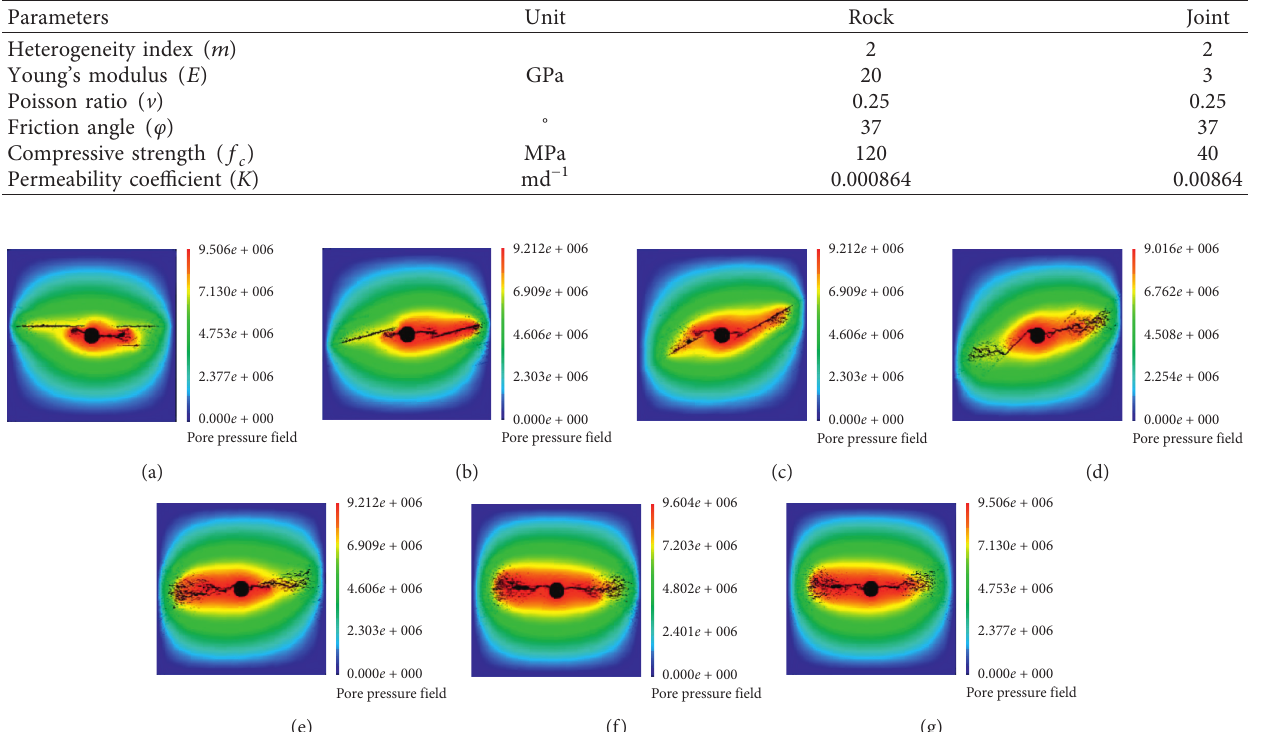
Figure 5: Pore pressure field of models with large confining pressure difference ( σ (d) α � 45 ° , (e) α � 60 ° , (f) α � 75 ° , and (g) α � 90 ° .